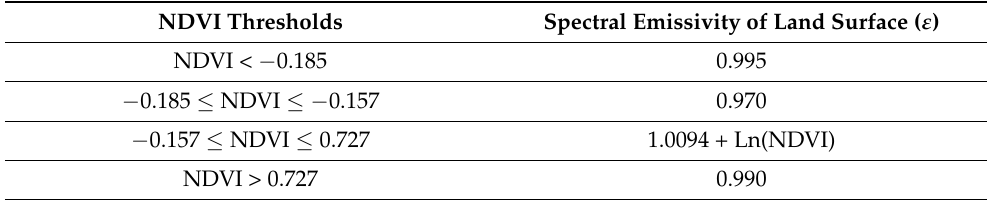
Table A3. NDVI thresholds for spectral emissivity of land